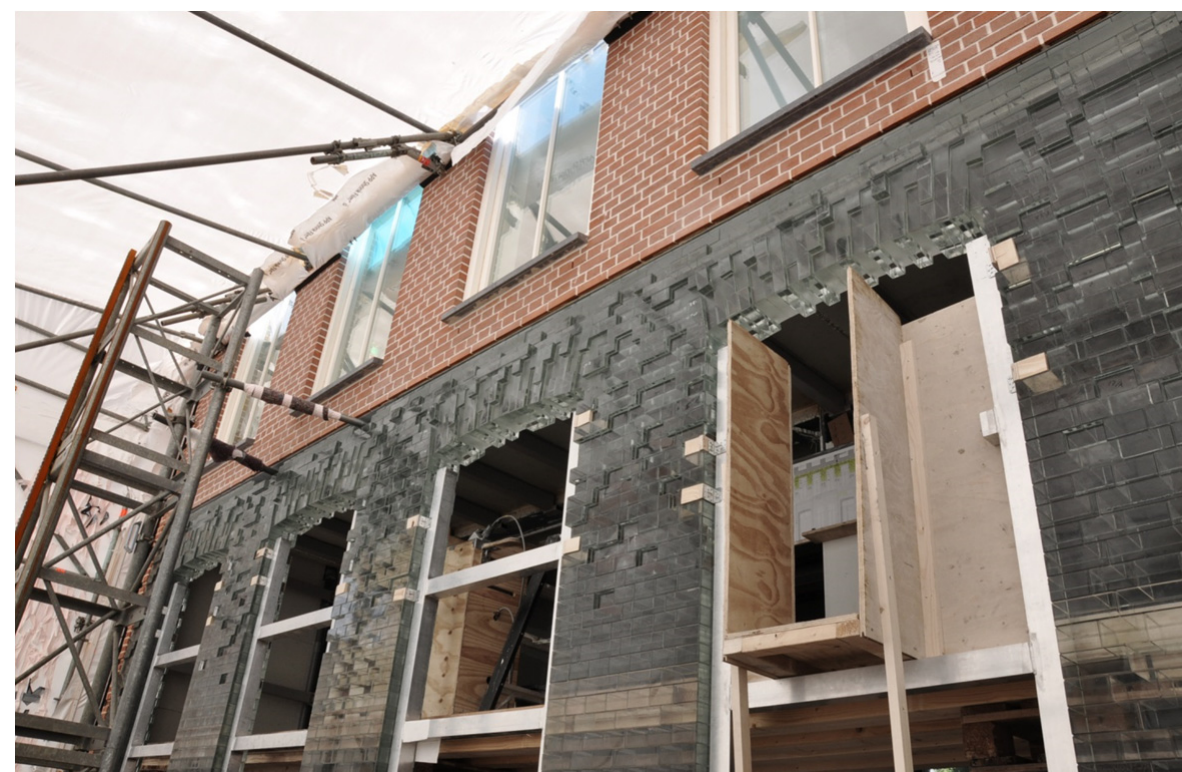
Fig. 9 Completed glass brick wall with the 40 mm narrower bricks bonded on location.